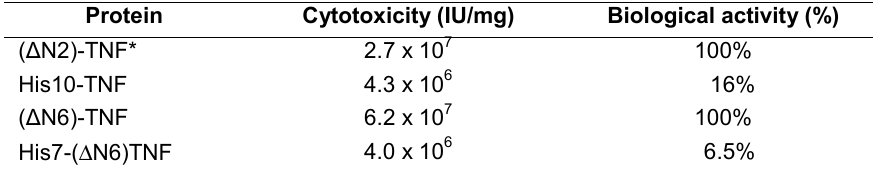
Biological Activity of His-Tagged TNF Proteins and Their Forms After Tag Removal